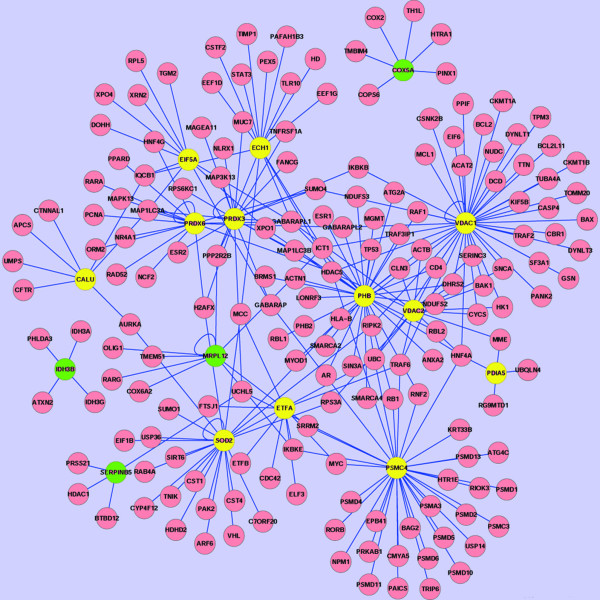
A protein-protein interaction sub-network of differentially expressed mitochondrial proteins between metastatic 5-8F and nonmetastatic 6-10B cells. It contains 193 nodes (red, green and yellow circles) and 252 edges (blue lines). A green circle means a down-regulated protein in metastatic 5-8F cells relative to nonmetastatic 6-10B cells. A yellow circle means an up-regulated protein in metastatic 5-8F cells relative to nonmetastatic 6-10B cells.